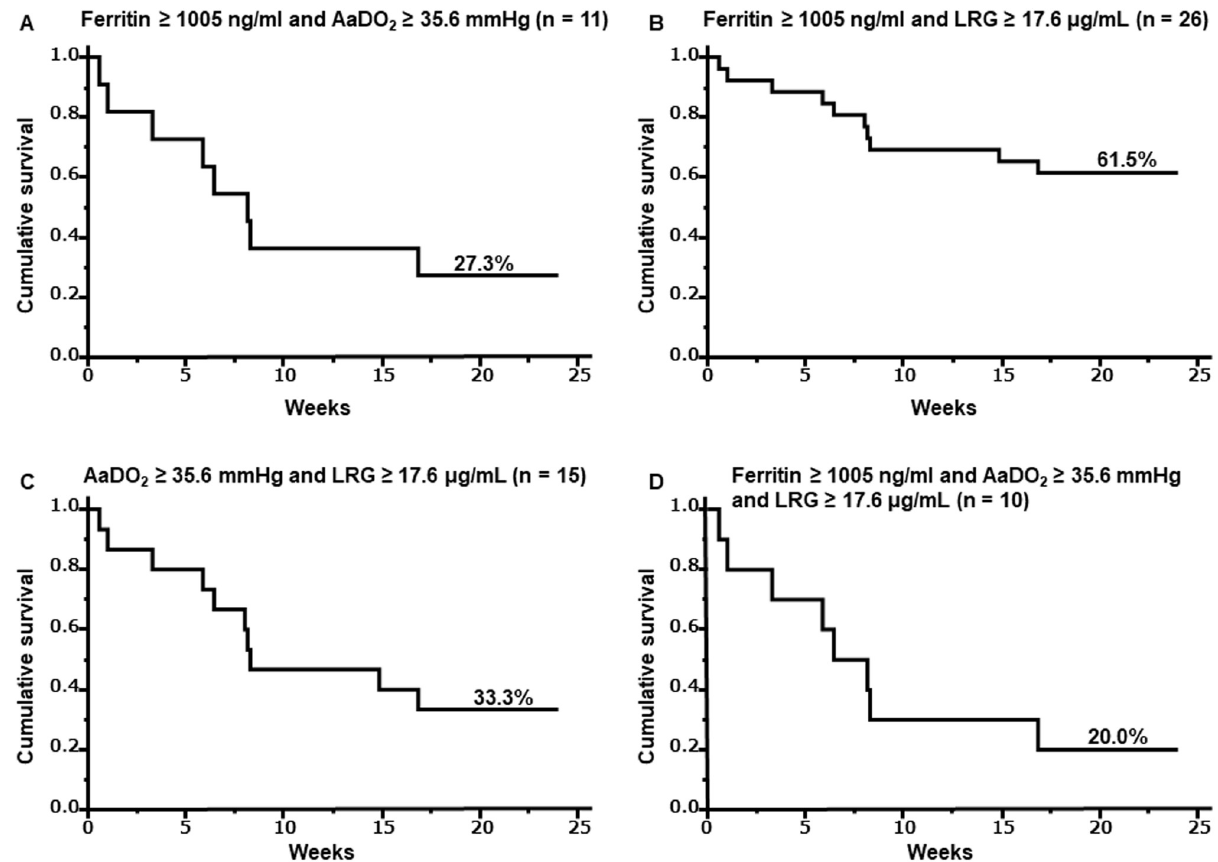
Fig 3. Survival curves using a combination of initial serum LRG and ferritin levels, and AaDO 2 level in DM-IP patients. The survival rate after 24 weeks was 27.3% for the patients with an initial serum level of ferritin � 1005 ng/ml and AaDO 2 � 35.6 mmHg. Solid line: Ferritin � 1005 ng/ml and AaDO 2 � 35.6 mmHg (A). The survival rate after 24 weeks was 61.5% for the patients with an initial serum level of ferritin � 1005 ng/ml and LRG � 17.6 μ g/mL. Solid line: Ferritin � 1005 ng/ml and LRG � 17.6 μ g/mL (B). The survival rate after 24 weeks was 33.3% for the patients with an initial AaDO 2 � 35.6 mmHg and serum level of LRG � 17.6 μ g/mL. Solid line: AaDO 2 � 35.6 mmHg and LRG � 17.6 μ g/mL (C). The survival rate after 24 weeks was 20.0% for the patients with an initial serum level of ferritin � 1005 ng/ml, AaDO 2 � 35.6 mmHg, and initial serum level of LRG � 17.6 μ g/mL. Solid line: Ferritin � 1005 ng/ml and AaDO 2 � 35.6 mmHg and LRG � 17.6 μ g/mL (D). Survival rates were calculated by the Kaplan- Meier method and compared by a log-rank test. � P < 0.05. DM, dermatomyositis; IP, interstitial pneumonia; LRG, leucine-rich α 2-glycoprotein; AaDO 2 , alveolar-arterial oxygen